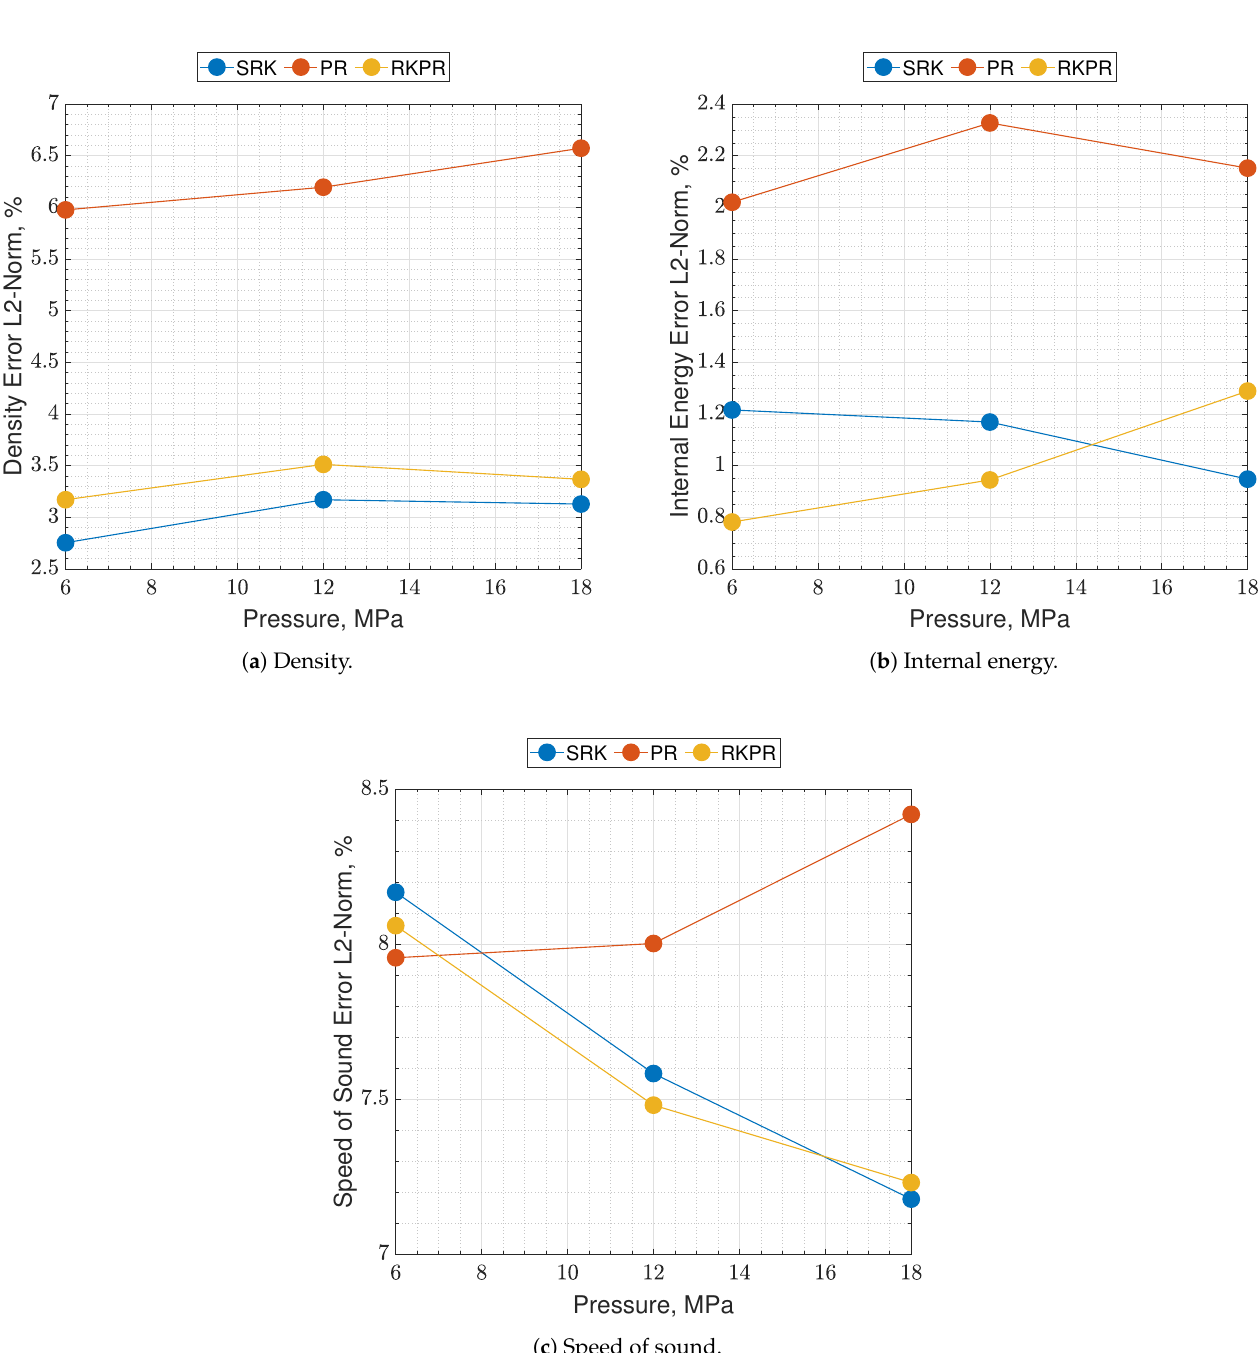
Figure 3. Percent errors of the present EoS in its SRK, PR and RK-PR operative modes with respect to refprop data. Species is pure O 2 . Errors are estimated as the nondimensionalized L2-norms calculated between the EoS results and the NIST dataset, over the whole temperature range, for a single pressure